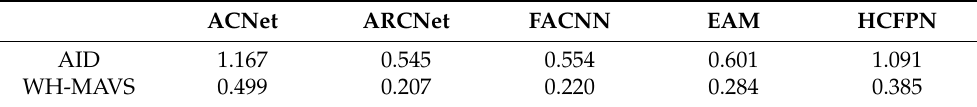
Table 7. Time statistics (in seconds) required to test models with HCFPN and other advanced comparison algorithms under 90% testing